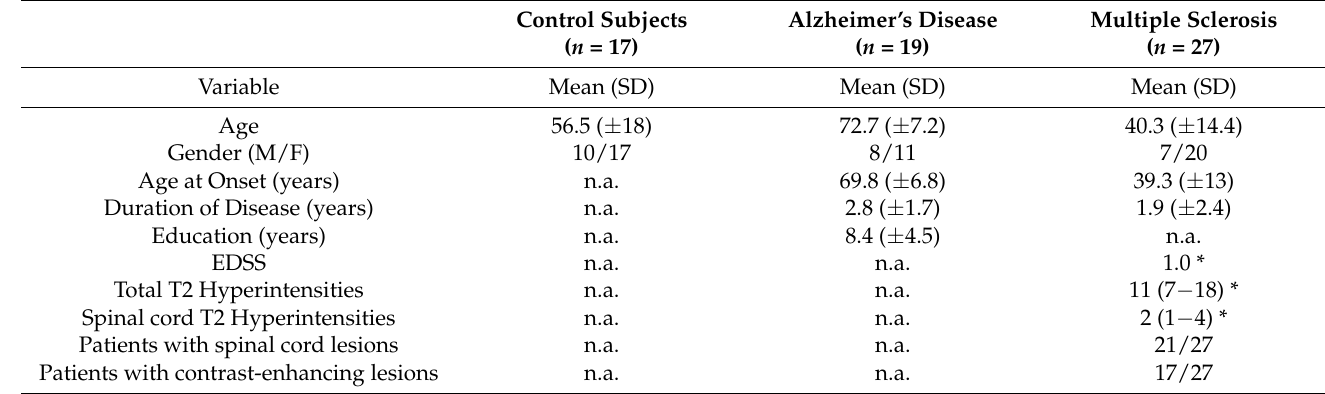
Table 1. Summary of the demographic and MRI characteristics of the study